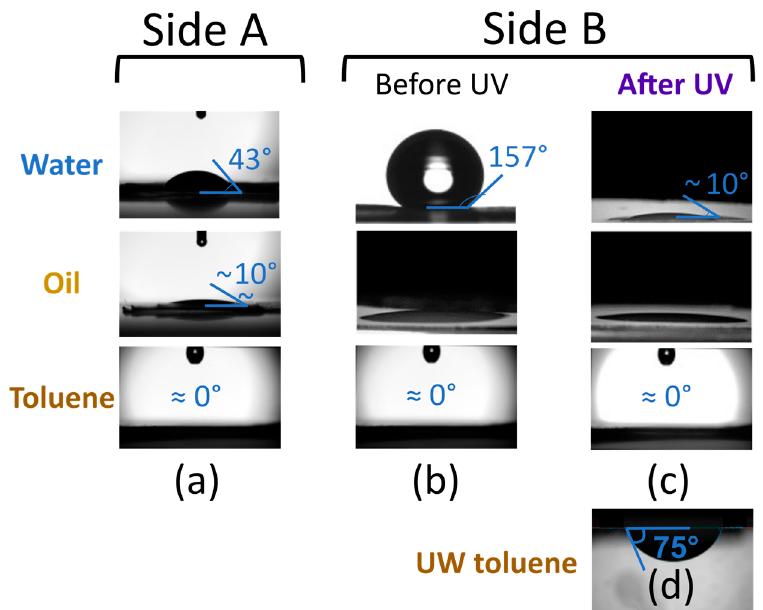
Figure 6. Water, toluene, and oil contact angle on Side A ( a ), Side B ( b ), and Side B after UV treatment ( c ). The underwater (UW) toluene contact angle on Side B after UV treatment is shown in ( d ).